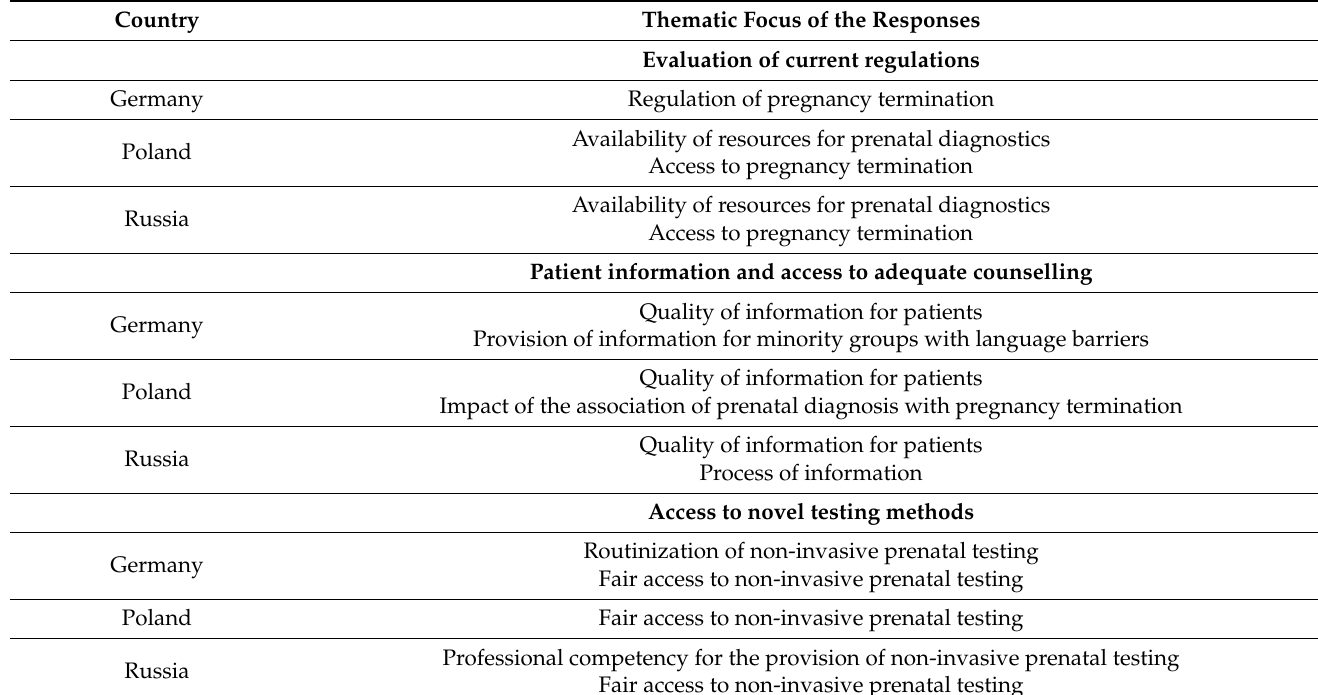
Table 1. Thematic focus of the responses in each